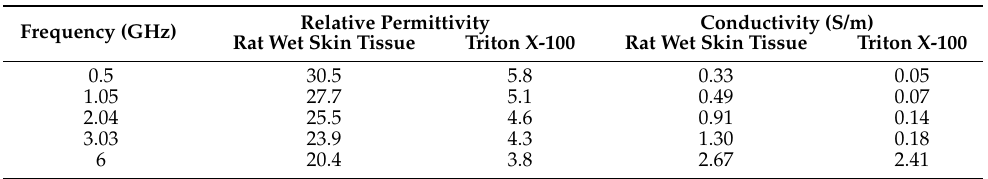
Table 7. The relative permittivity and conductivity of pure materials (rat wet skin tissue and triton X-100) at five frequency points.